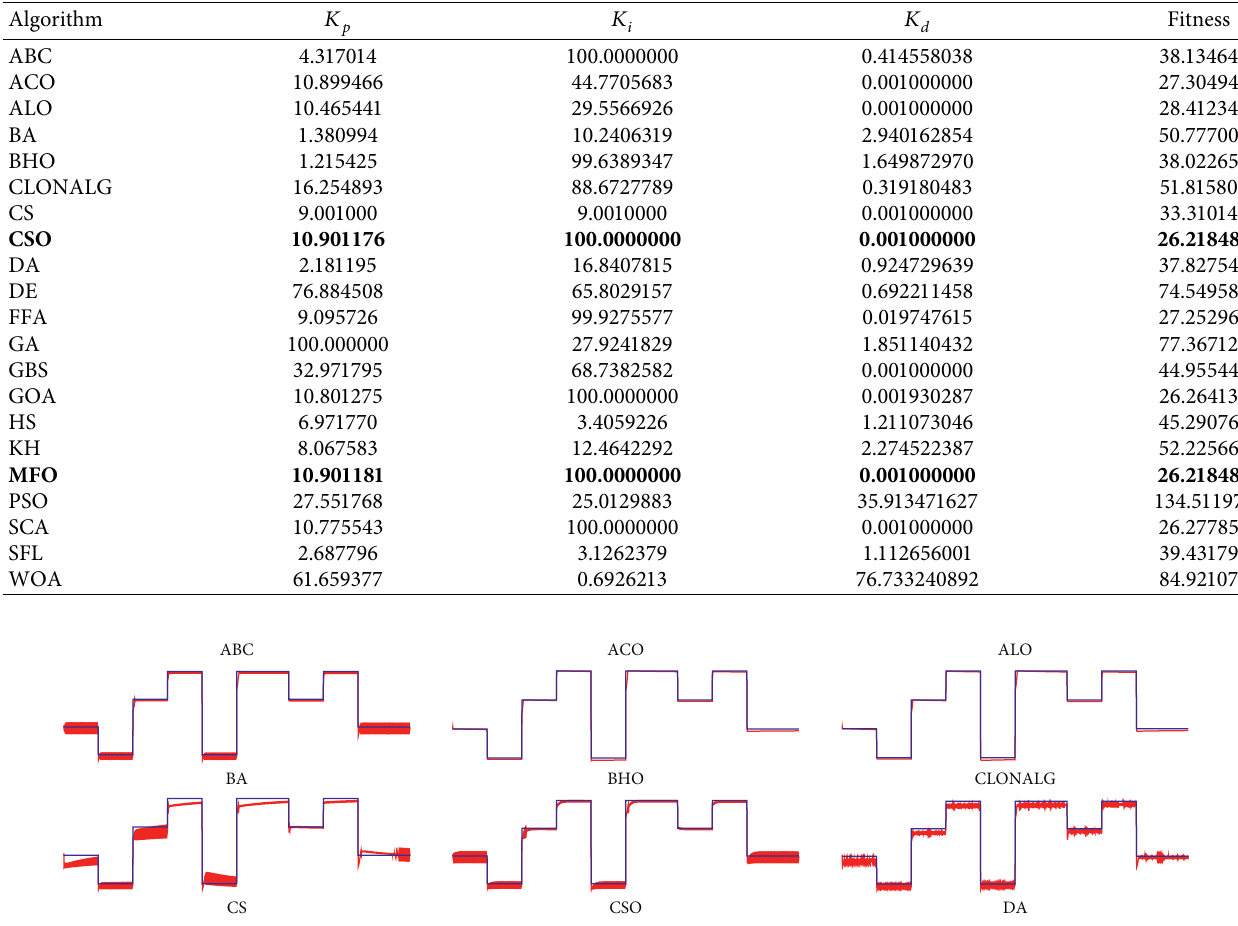
, see equation (3) and Figure 7. 3